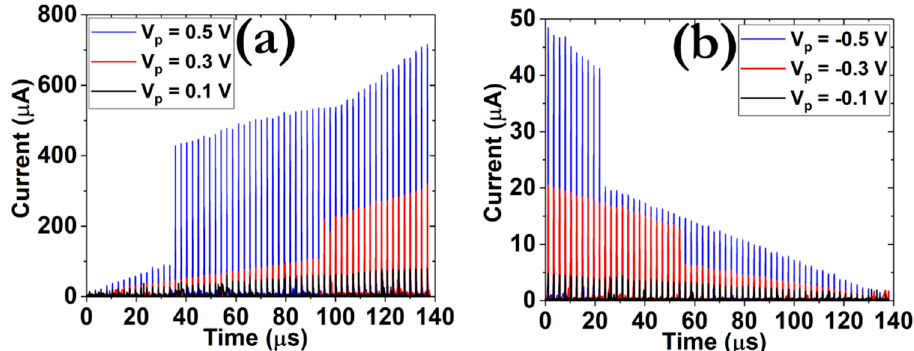
Figure 5. Distribution of the post-synaptic current responses during the implementation of the ( a ) potentiation and ( b ) depression procedures, under the application of total 60 pre-synaptic pulses with 100 ns width and amplitudes of ±0.1, ±0.3 and ±0.5 V, respectively.